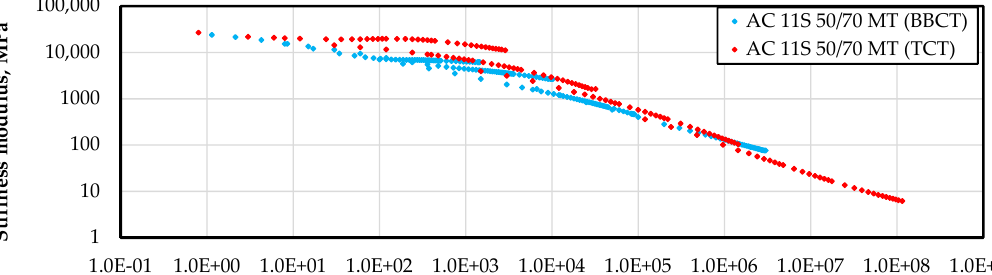
◦ C. Appl. Sci. 2019 , x